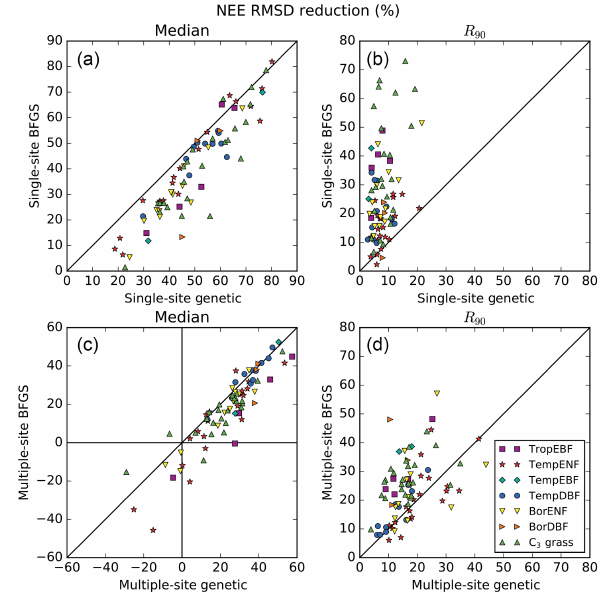
Figure 2. Comparison of the performances between the gradient- based and genetic methods in terms of model–data RMSD reduction (%) obtained for the daily NEE fluxes. The left panels show the medians from the results obtained within 16 optimisation tests with random first-guess parameter values for each site; the right panels show the spreads between the 5th and 95th percentiles ( R 90 ) of the same